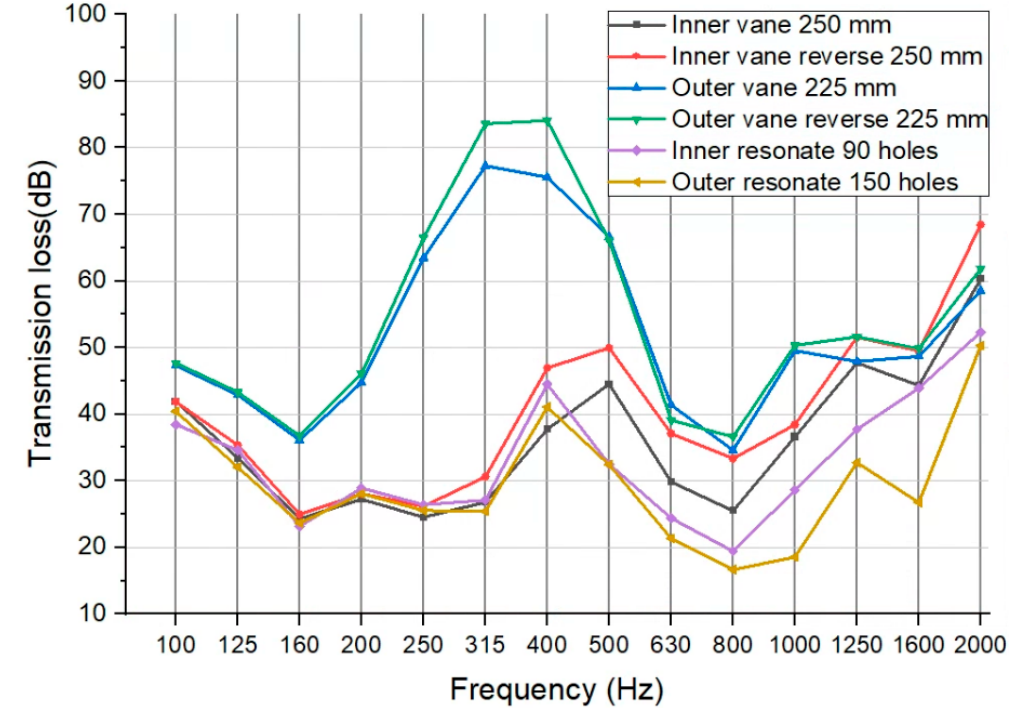
Figure 32. Transmission loss according to the frequency for optimal cases.